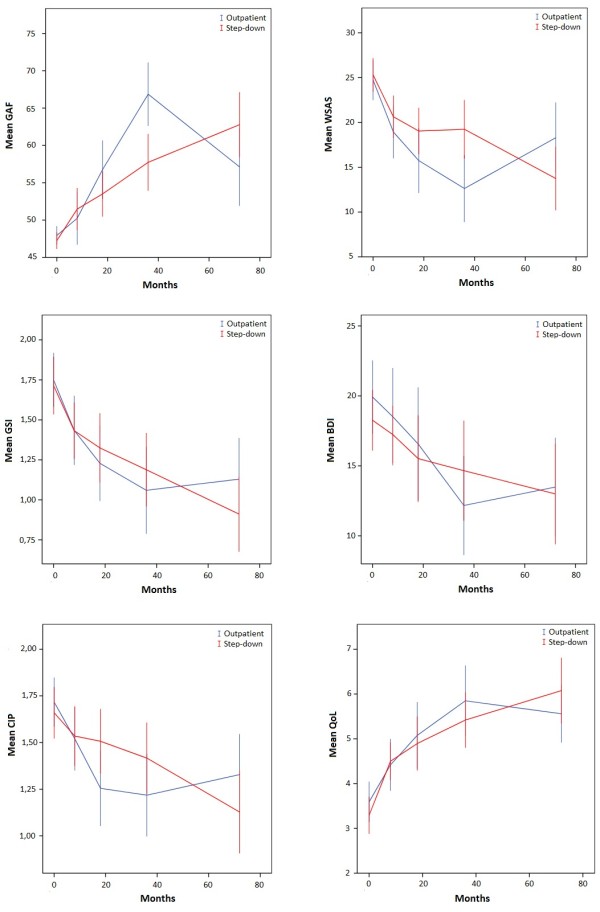
Course of primary outcome variables.